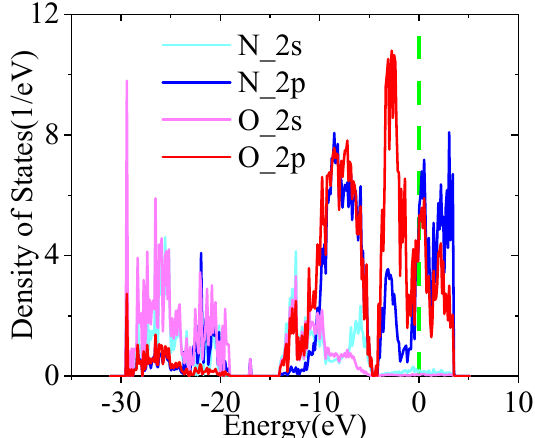
Figure 12. The partial density of states of NO at 1.92 g cm − 3 and 2000 K using PBE functional. The Fermi level is shown as the green dashed line.